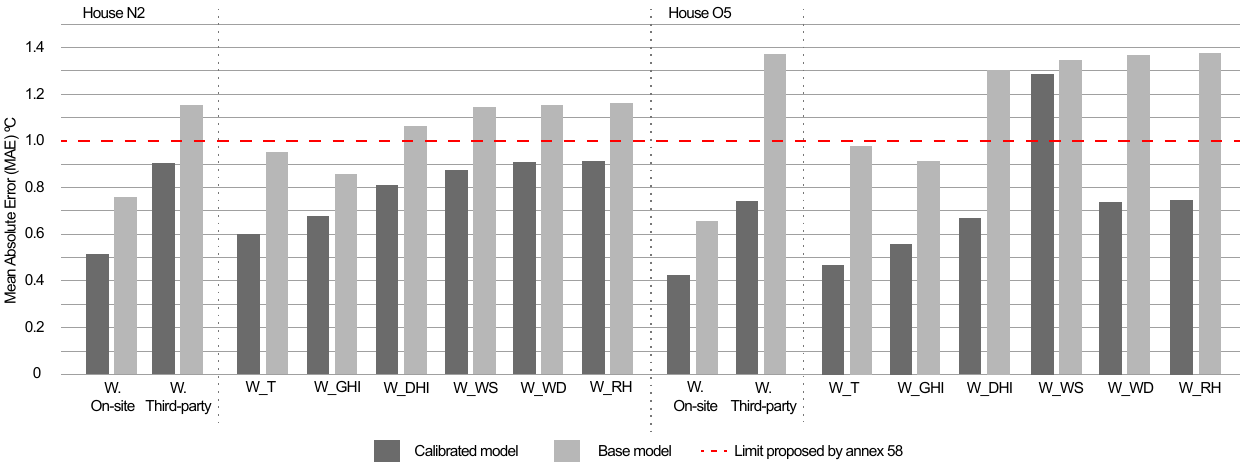
Figure 8. Results of the MAE index of the base and calibrated models with the different weather files created. Checking period, Houses N2 and